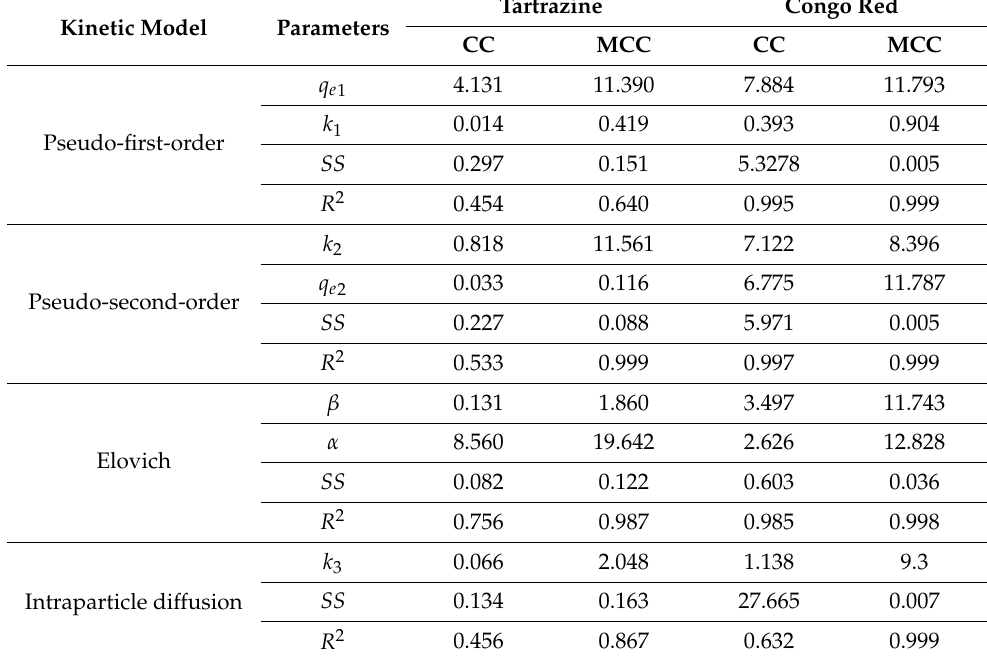
Figure 6. Adsorption kinetics of ( a ) tartrazine and ( b ) Congo Red on adsorbents from coconut mesocarp; at pH 4, 30 ◦ C, initial concentration of 100 mg/L and 5 mg/L of adsorbent dose.